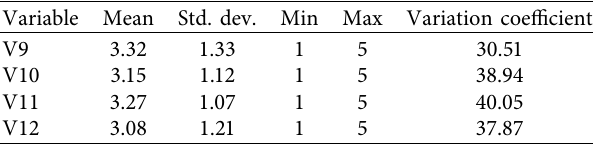
Table 4: Variation coefficient of learners’ motivation.